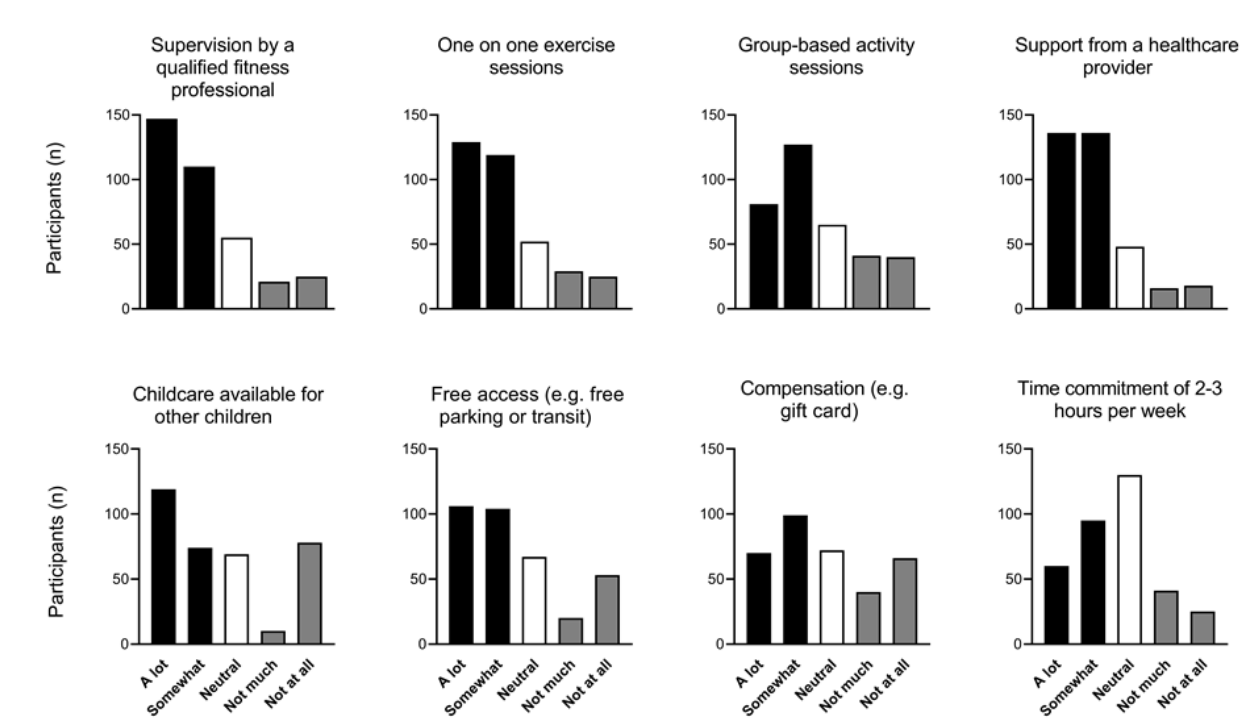
Figure 2. Factors that would positively influence participation in physical activity research in multifetal pregnancy.